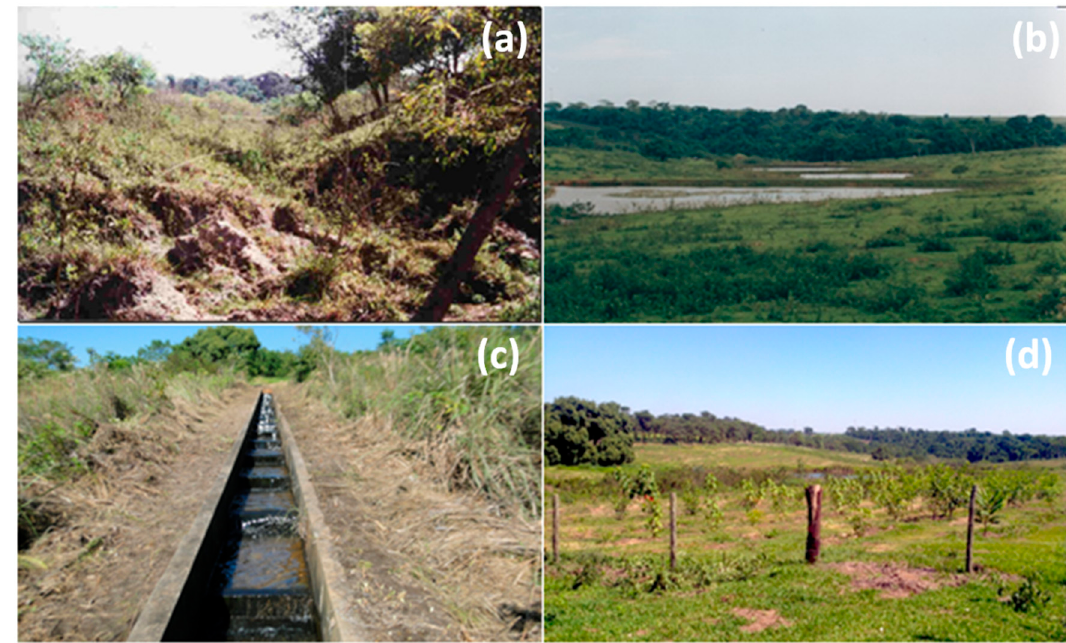
Figure 5. History of recovery and reforestation of degraded area in sub-basin 1.2: ( a ) intense erosion and gullies; ( b ) formation of four uneven reservoirs; ( c ) drainage channels; and ( d ) implementation of reforestation and the Agro-forestry System.